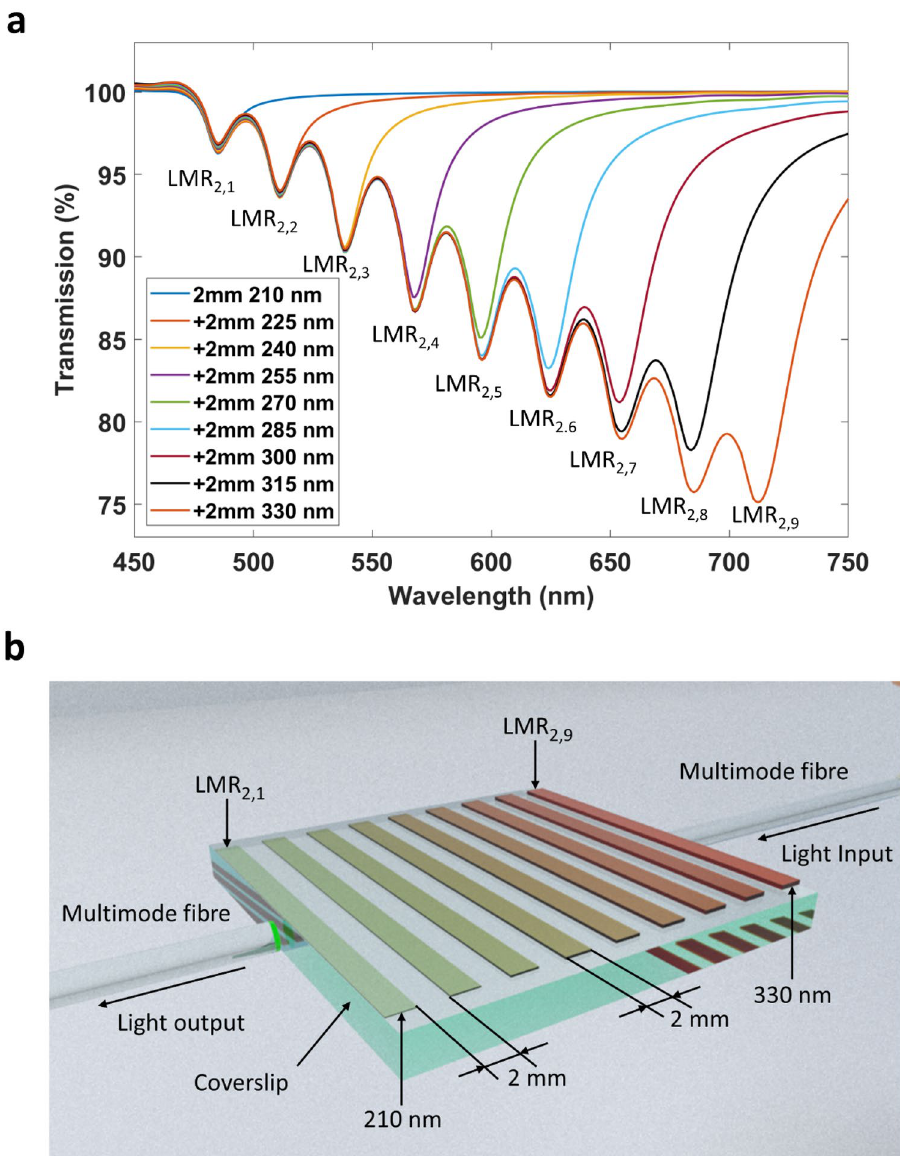
Figure 7. Array of 9 LMRs. (a) Simulation of the progressive addition of 2 mm electrodes, each one nanocoated to a different thickness, which permits generation of multiple LMRs in the transmission spectrum. The structure was surrounded by air (RI = 1). (b) Schematic representation of the array of 9 electrodes generating the corresponding 9 LMR-based sensors, where each one is identified with the resonance peaks of the graphic